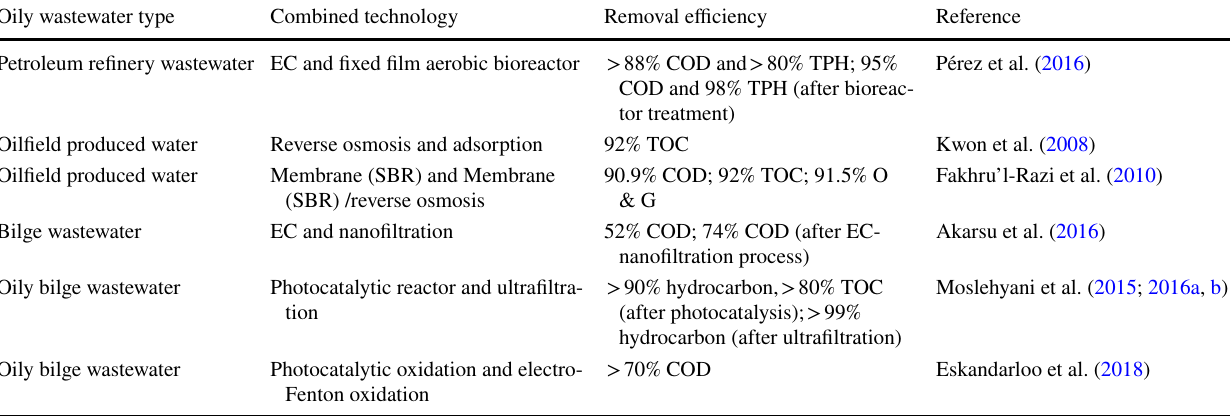
Table 6 Efficiencies of combined technologies in the removal of pollutants from oily wastewater Oily wastewater